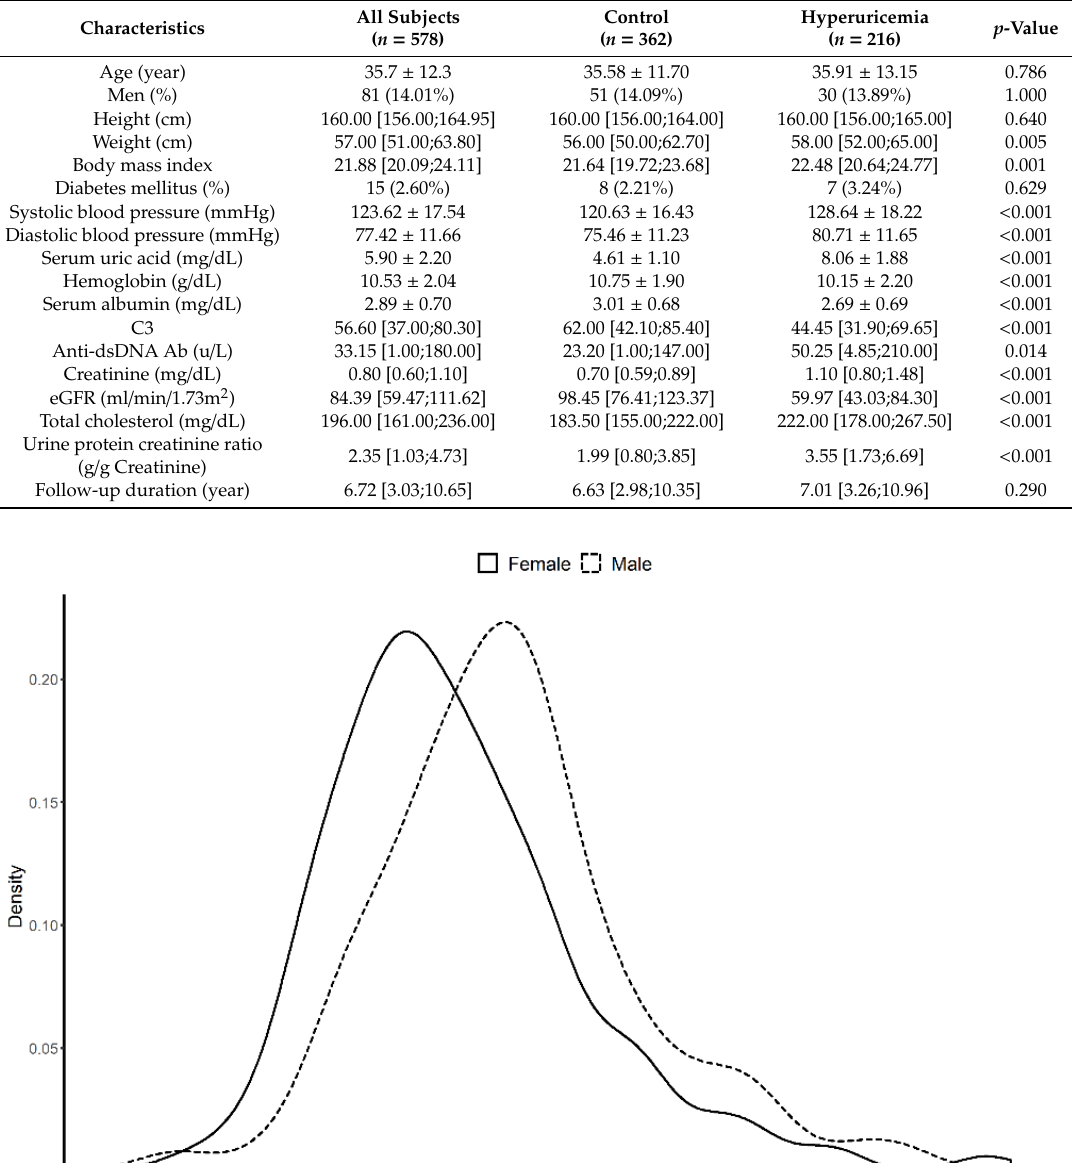
Table 1. Clinical characteristics of the subjects stratified by hyperuricemia.